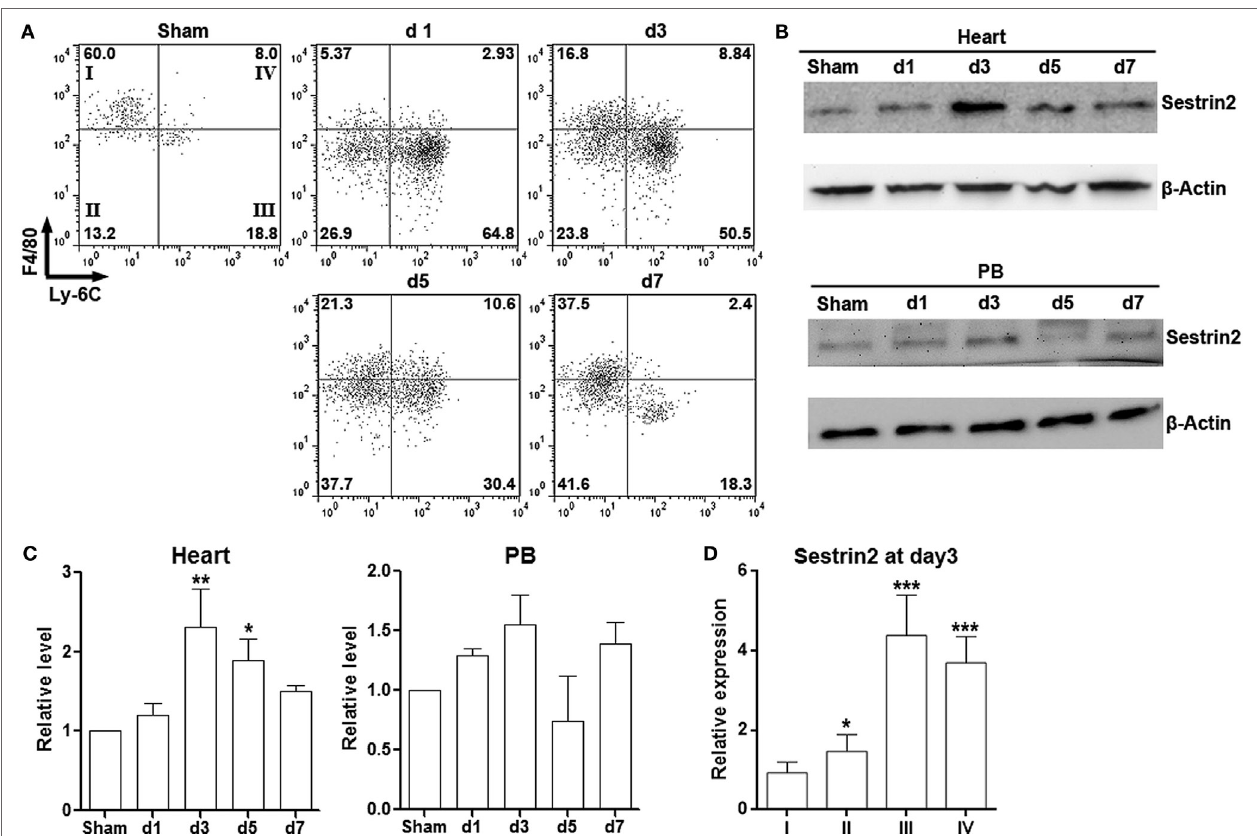
FigUre 1 | Sestrin2 is expressed in cardiac macrophages after myocardial infarction (MI). (a) Representative flow cytometry dot plots showing cardiac macrophage subpopulations in infarcted myocardium at day 1, day 3, day 5, and day 7 after MI. Numbers in the quadrants are proportions of corresponding subpopulations. Sham: Sham-operated animal. This is a representative of three independent experiments. (B) Sestrin2 protein levels in total cardiac macrophages (upper panel) and blood monocytes (lower panel). (c) Statistics for (B) . N = 3 per group. * p < 0.05; ** p < 0.01; *** p < 0.001 compared with d1 group. (D) mRNA abundance of Sestrin2 in four cardiac macrophage subpopulations at day 3 after MI. * p < 0.05; ** p < 0.01; *** p < 0.001 compared with subpopulation